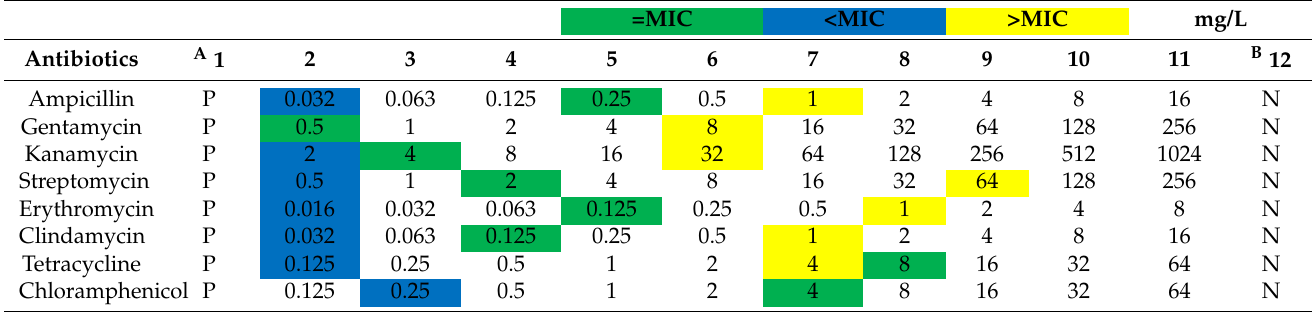
Table 2. Antibiotic susceptibility assay (MIC test) of L. plantarum